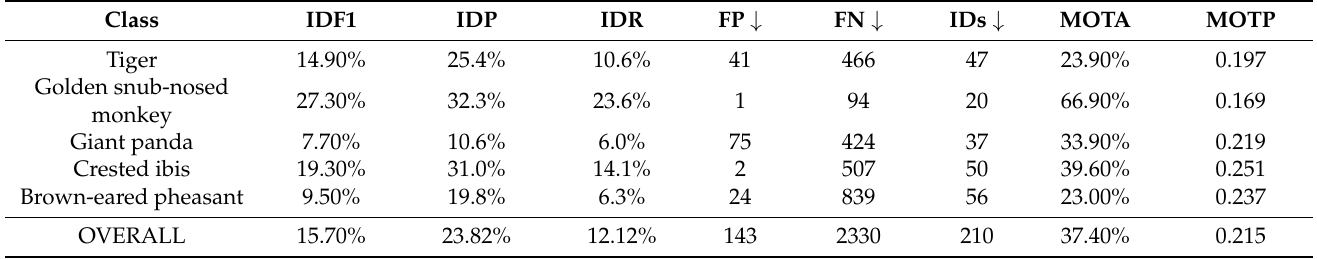
Table A3. Results of the same few-shot object detector in our model combined with IoU-tracker tracker on the MOT-EA dataset.